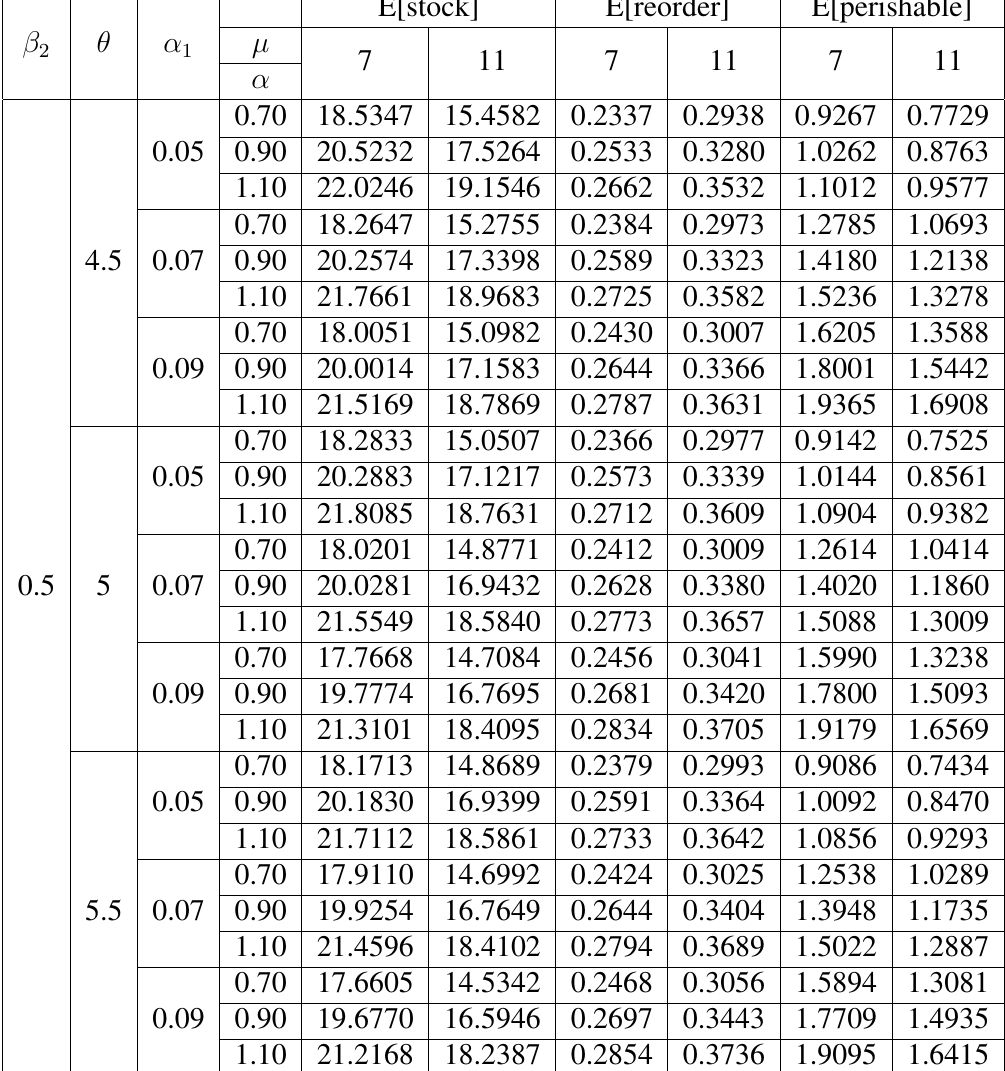
Table 6: Impact of E[psl], E[reorder and E[perishable] with the parameter variation β